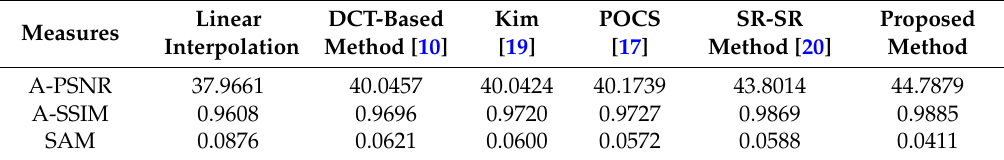
Figure 9. False color image of experimental results for the Jinyin Tan dataset 1 (color composite of R: 48, G: 30, B: 11). ( a ) original HR image; ( b ) linear interpolation results; ( c ) DCT-based method [10] results; ( d ) Kim [19] results; ( e ) POCS [17] results; ( f ) SRSR [20] results; ( g ) proposed APOCS-BM method results. Table 3. Comparison results of A-PSNR, A-SSIM and SAM on Jinyin Tan dataset